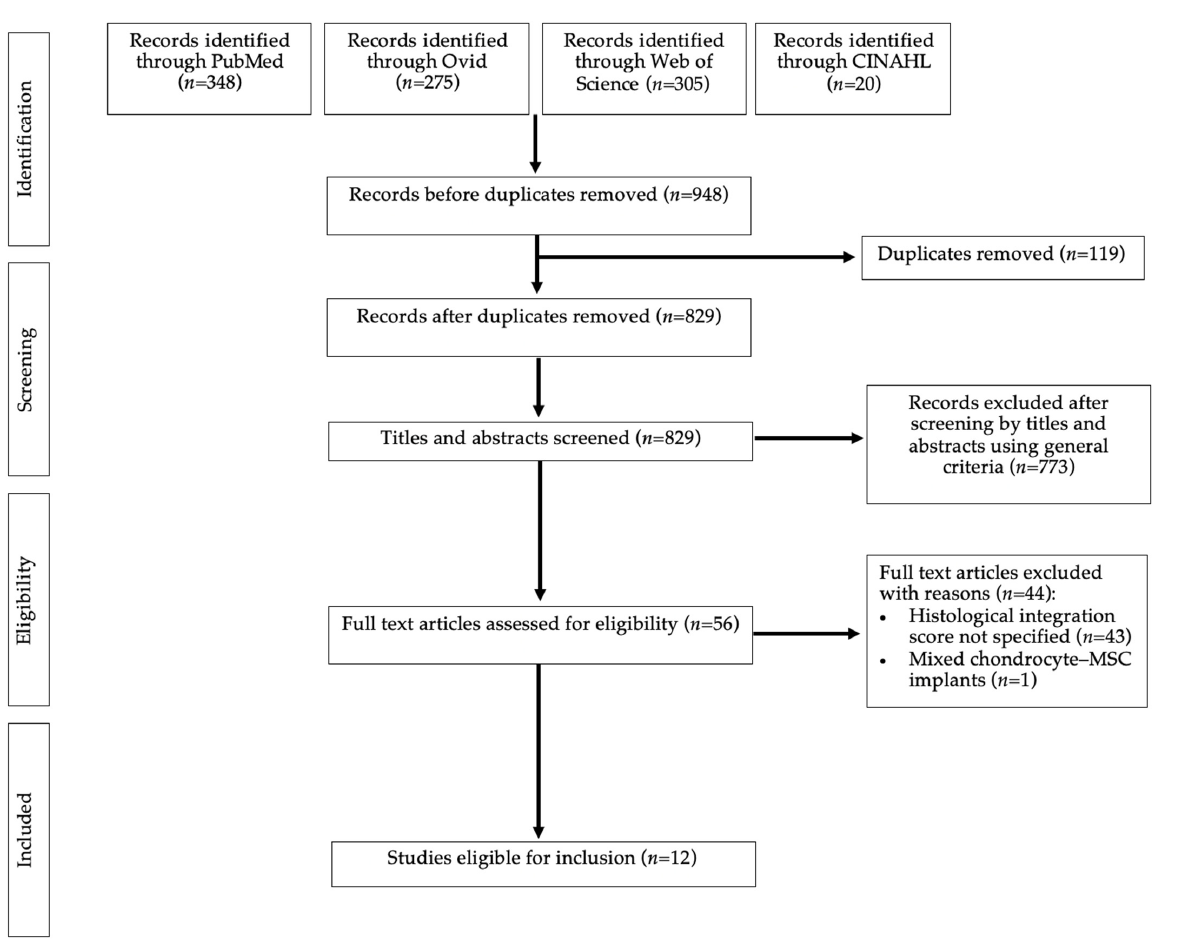
Figure 5. A PRISMA flow-chart representing article screening and selection.